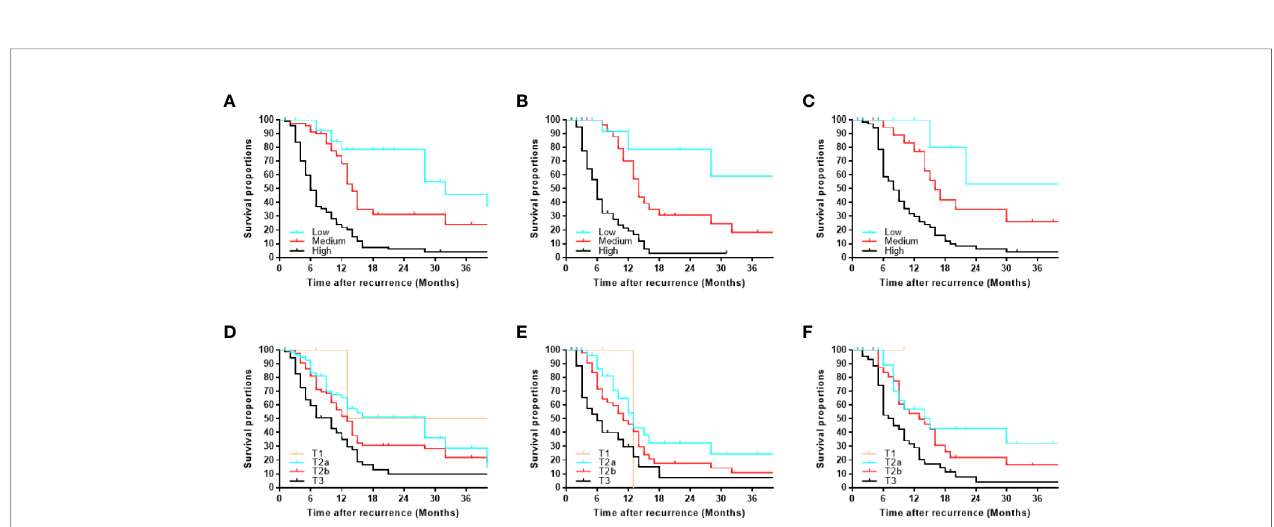
FIGURE 5 | Kaplan-Meier post-recurrence survival curves for each risk subgroup of patients. Patients were strati fi ed by our monogram in the (A) training, (B) internal, (C) external validation cohort. Patients were strati fi ed by the T category in the (D) training, (E) internal, (F) external validation